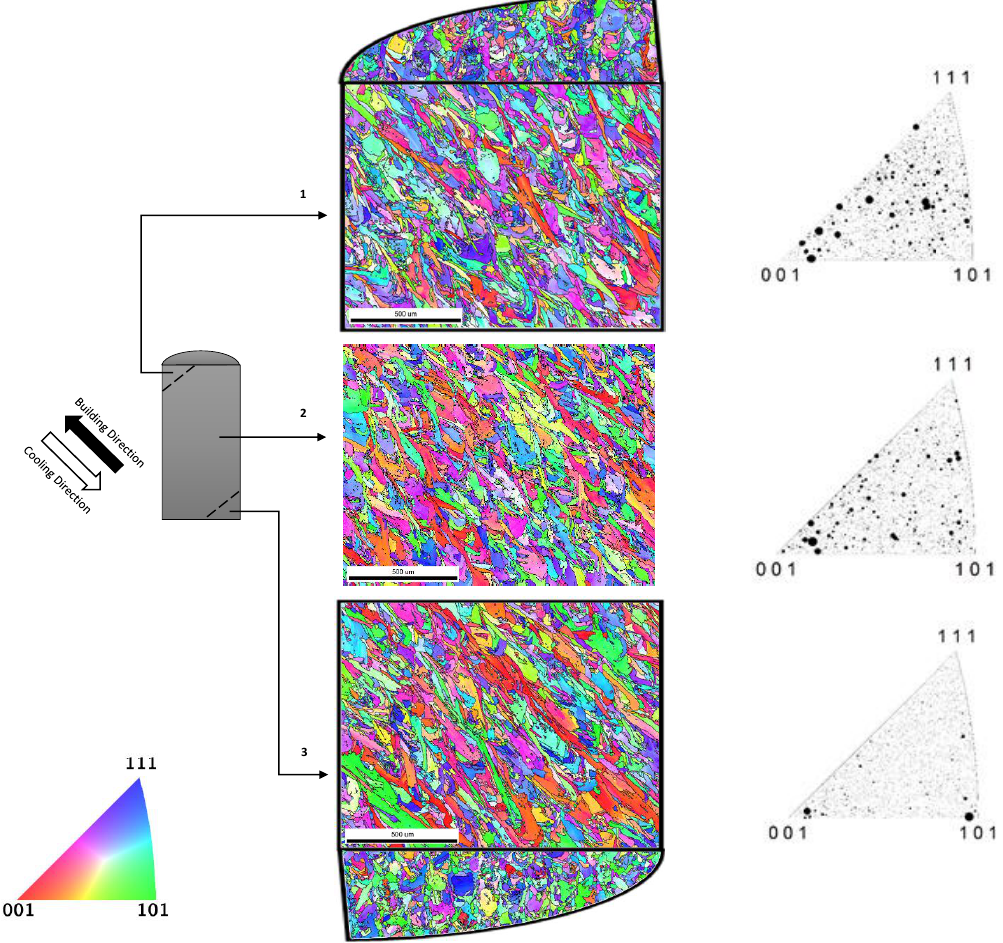
Figure 11. EBSD inverse pole maps at the ( 1 ) top, ( 2 ) middle, and ( 3 ) bottom of the as-printed specimen. Inverse pole figures to the right of the maps represent the vertical cross-sections. The evolution of orientation in vertical cross-sections of the as-printed specimen from the mainly (001) and (101) directions at the bottom to a (001) dominant orientation with some (111) and (101) oriented grains at the top, as can be seen in Figure 11. Average grain sizes and morphologies also differ dramatically between the top and bottom, as can be seen in Table 3. Long, thin grains are visible at the bottom of the vertical cross-section. This is quantified by the aspect ratios at the locations 3 (0.253), 2 (0.275), and 1 (0.277) with the bottom having the smallest aspect ratio and the top having the largest. Deviation in grain size and shape is also larger at location 3 in the vertical section, indicating a mixture of large and small columnar and equiaxed grains. Due to the high relative cooling rates at the bottom of the vertical cross-section, grains are stretched towards the cooling direction. Average equivalent grain diameter is larger at the bottom of the vertical section (65 µm) than at the middle (56 µm) which is close to the top (55 µm). Both the bottom and top horizontal cross-sections show that the tops of the columnar grains have a more equiaxed shape with aspect ratios of (0.392) at location 3 and (0.371) at location 1 in Figure 11. The top horizontal section displays larger average grain sizes and a larger aspect ratio in the corresponding vertical section than the bottom due to lower cooling rates.